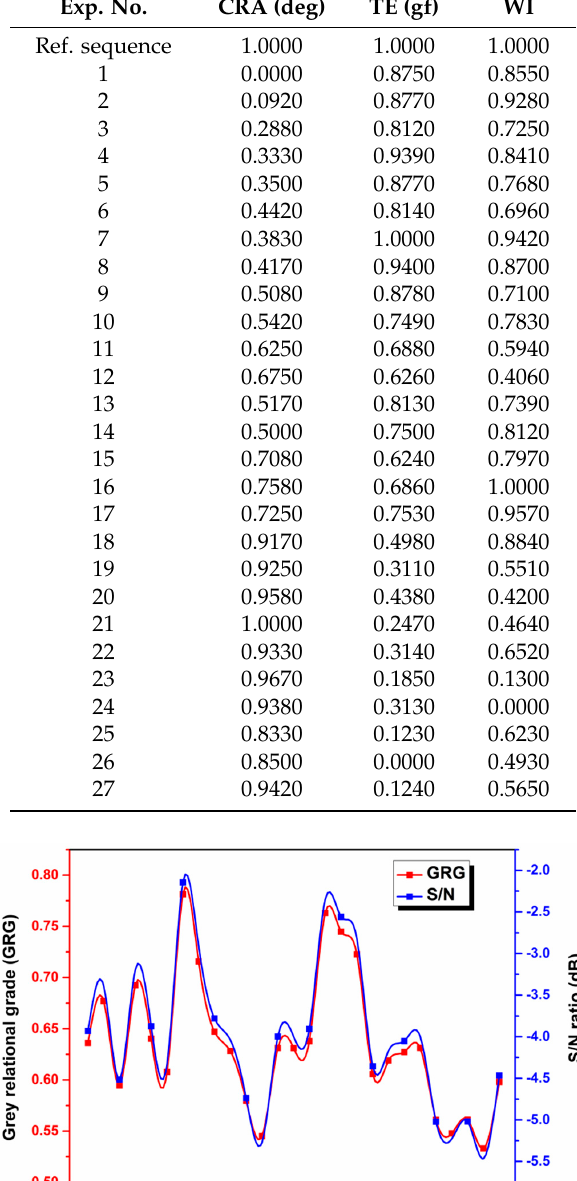
Table 9. Sequence of the performance characteristics after data pre-processing. Exp. No.